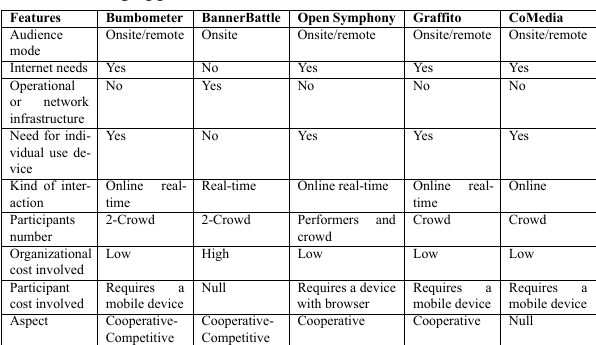
Table 5. Comparative table between the Bumbometer and other crowdsourcing